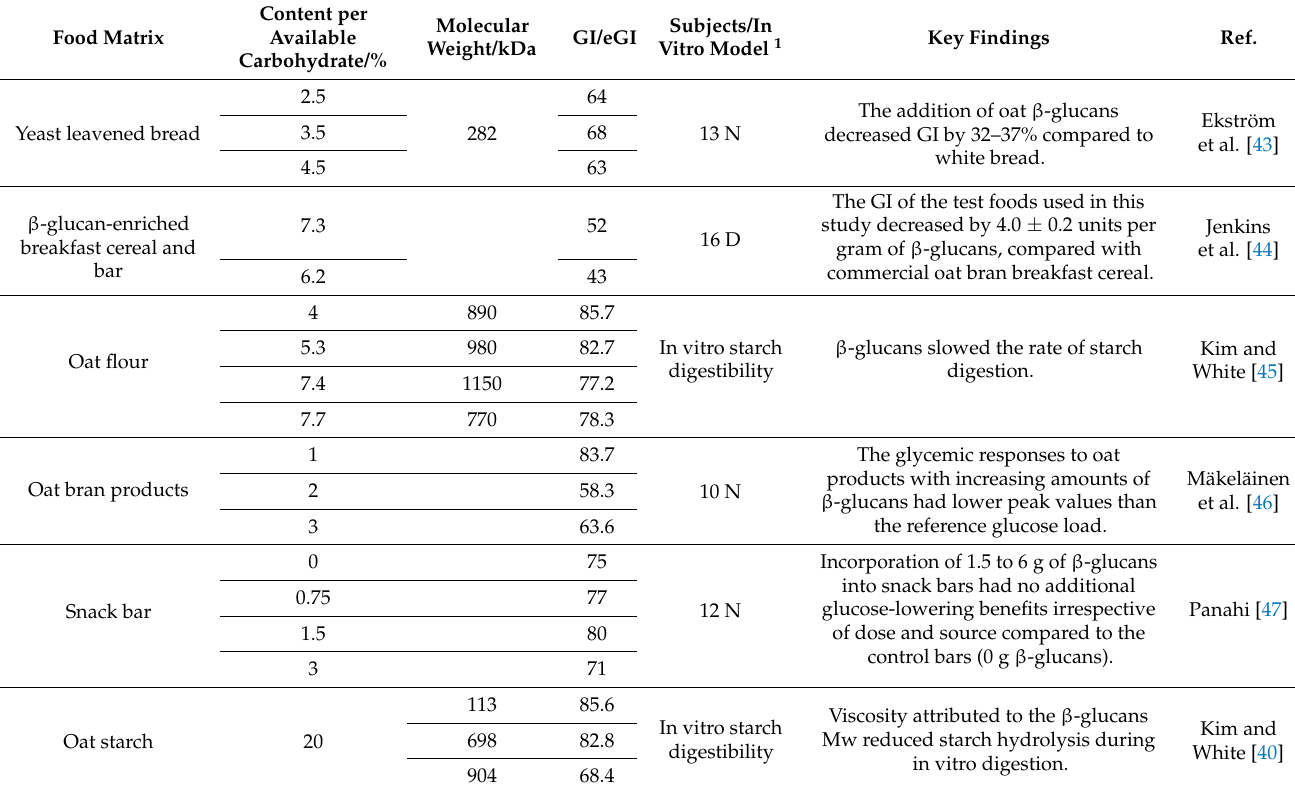
Table 1. Inclusion of oat β -glucans in varied food matrices and corresponding GI